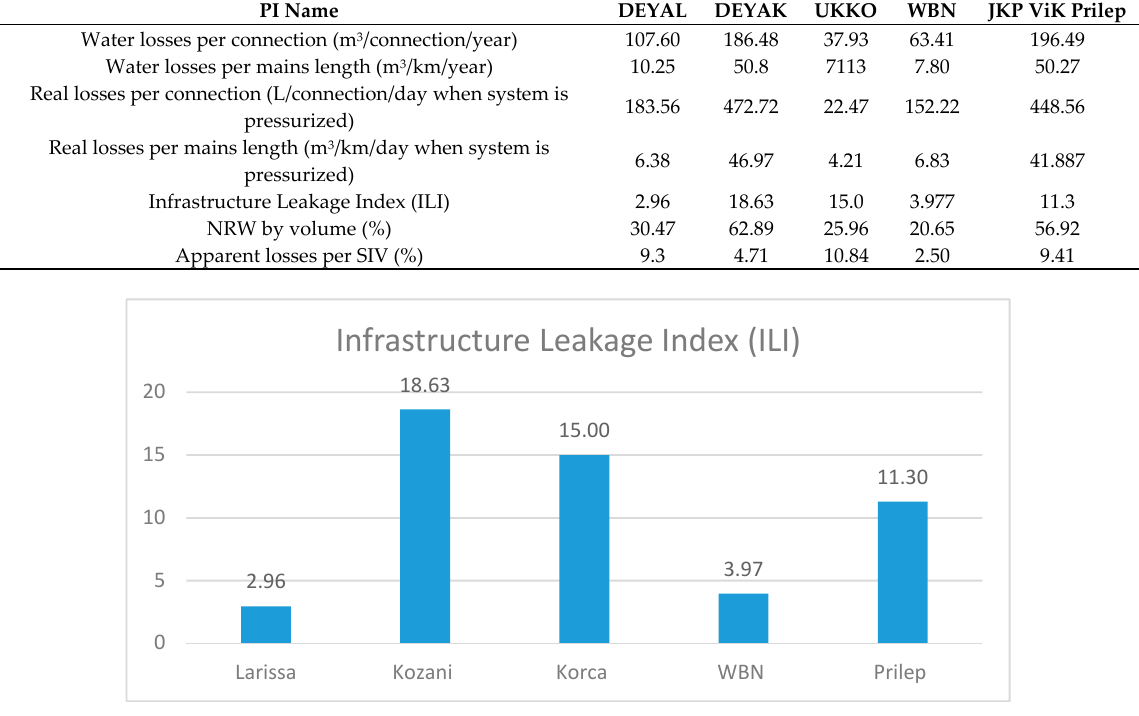
Figure 4. ILI values for all water